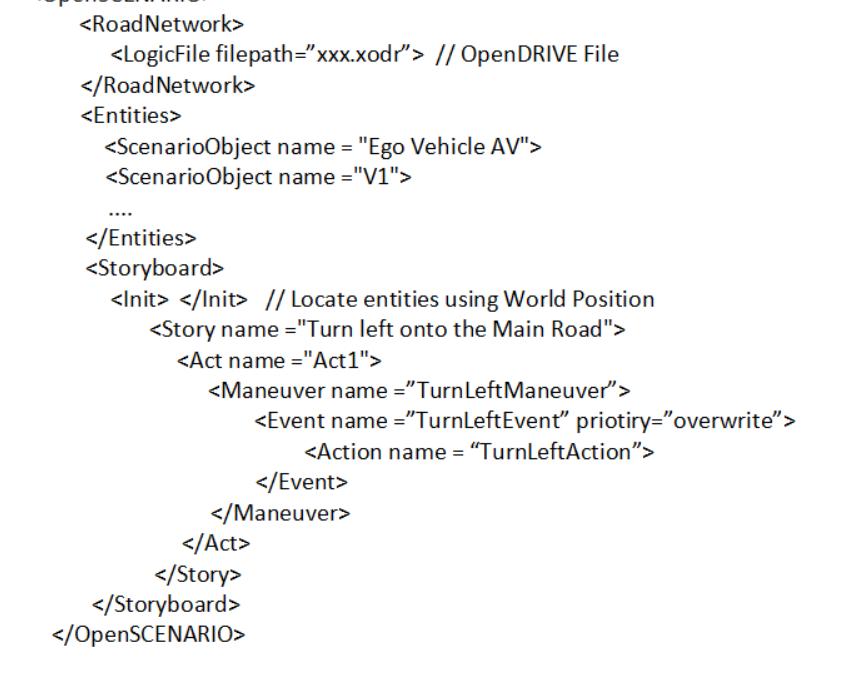
Figure 4. OpenSCENARIO description of part of example